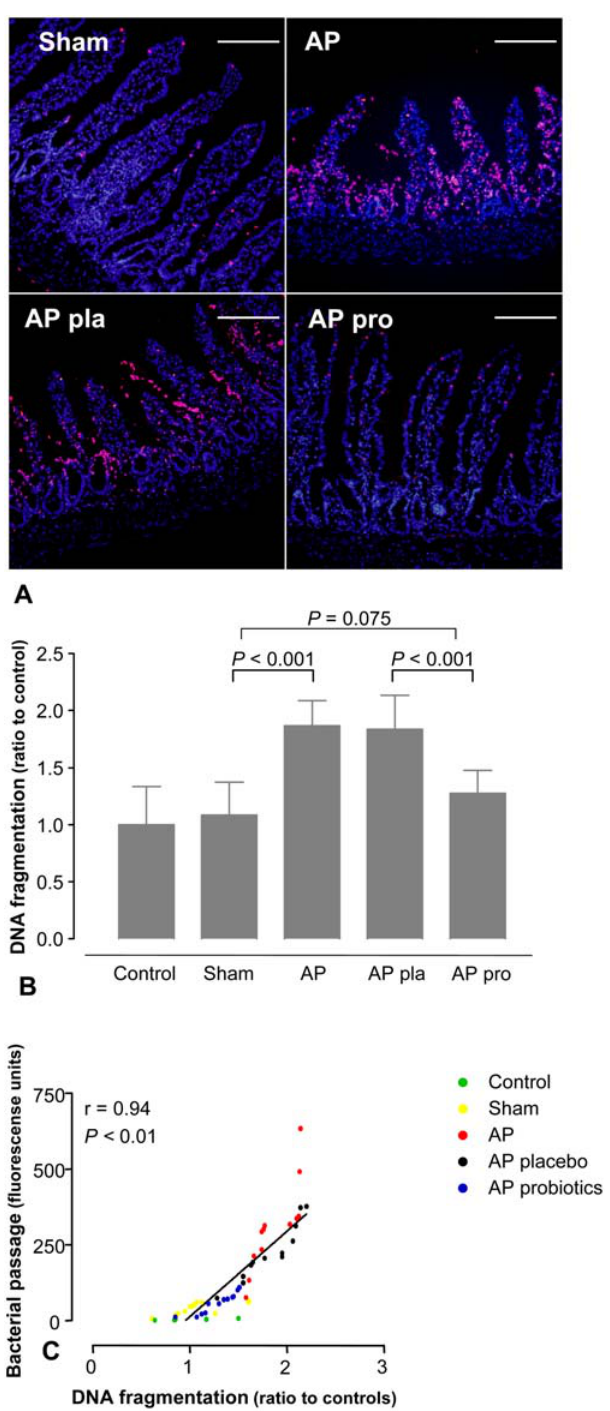
Figure 4. Probiotics reduced pancreatitis-associated intestinal apoptosis. After 5 days of pre-treatment with placebo or probiotics, rats were subjected to acute pancreatitis, or a sham-procedure. (A) Sections of ileum were TUNEL stained. The results shown are typical images from 4 sections of 4 rats per group. Bar=200 m m. (B) DNA- fragmentation (control n=5, sham n=12, AP n=12, AP pla n=12 and AP pro n=12). The graph shows the average ( 6 SD). Comparisons were performed using ANOVA followed by Tukey’s HSD. (C) Positive correlation between intestinal apoptosis and Escherichia coli K12 passage was computed using Spearman’s rank correlation